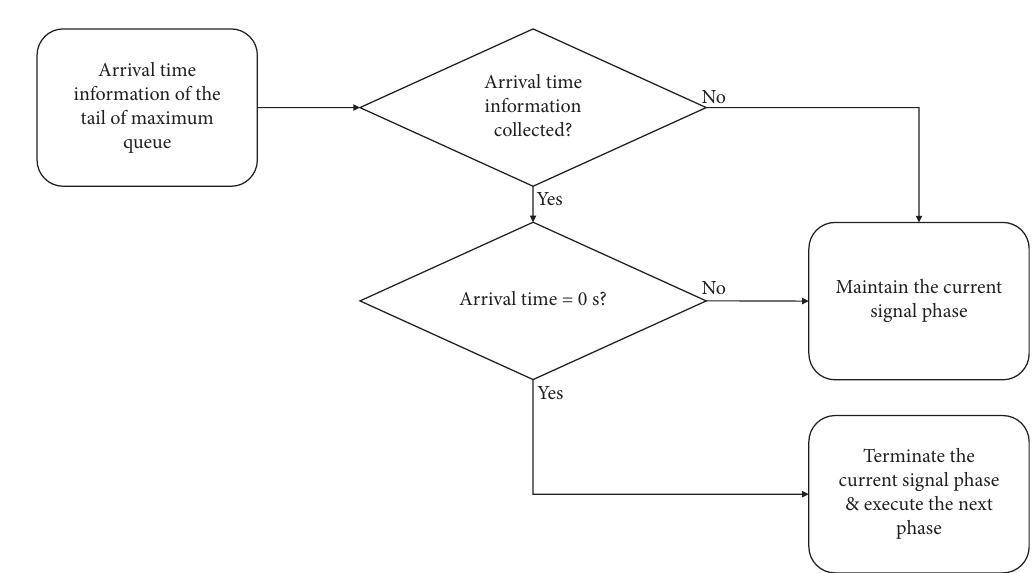
Figure 5: CWR intersection signal control algorithm. Table 3: Description of variables related to signal priority control for